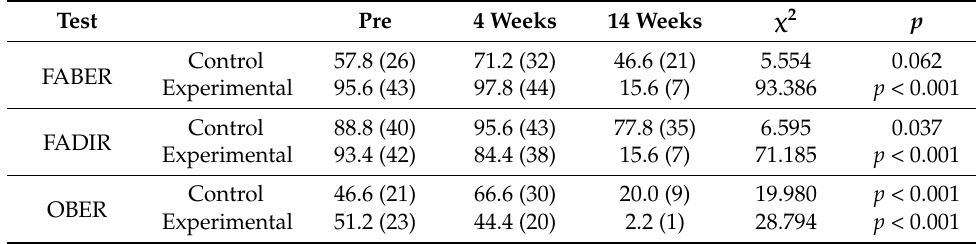
Table 2. Analysis of orthopedic